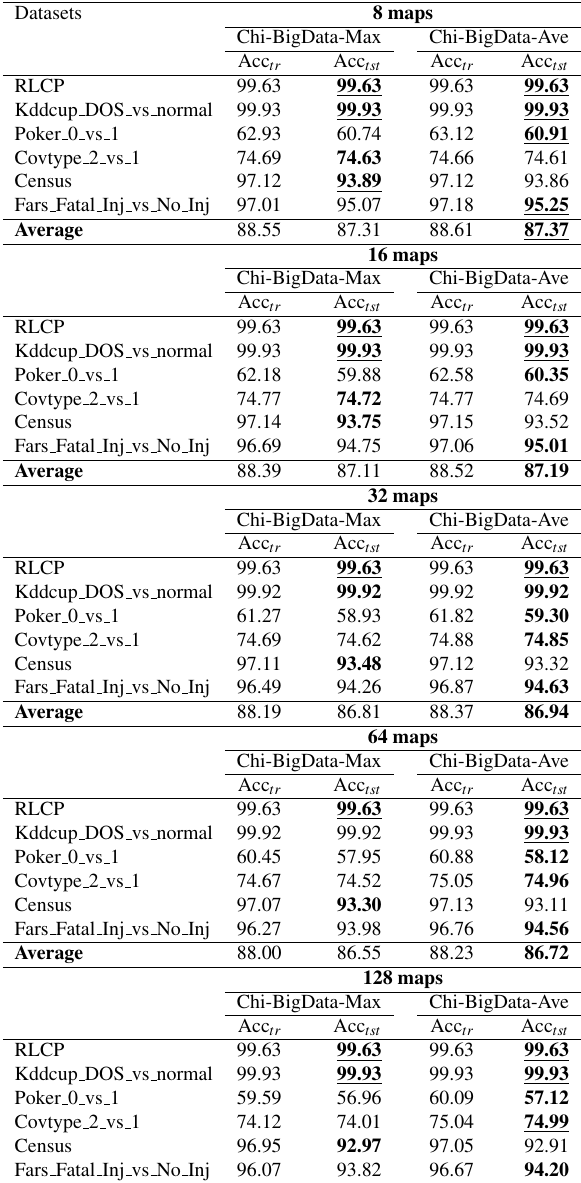
Table 7. Average Accuracy results for the Chi-FRBCS-BigData versions using 8, 16, 32, 64 and 128 maps